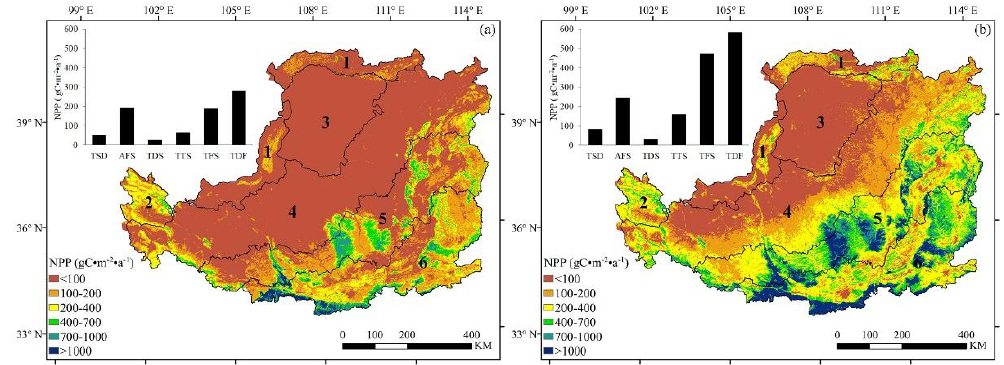
Figure 3. NPP distribution in ( a ) 2001 and ( b ) 2020 on the Loess plateau. The numbers on the pixels represent six sub-regions on the LP: (1) temperate steppe desert (TSD), (2) alpine forest – steppe (AFS), (3) temperate desert – steppe (TDS), (4) temperate typical steppe (TTS), (5) temperate forest – steppe (TFS), (6) temperate deciduous forest (TDF). Bar charts show the average NPP in six sub- regions in 2001 and 2020.